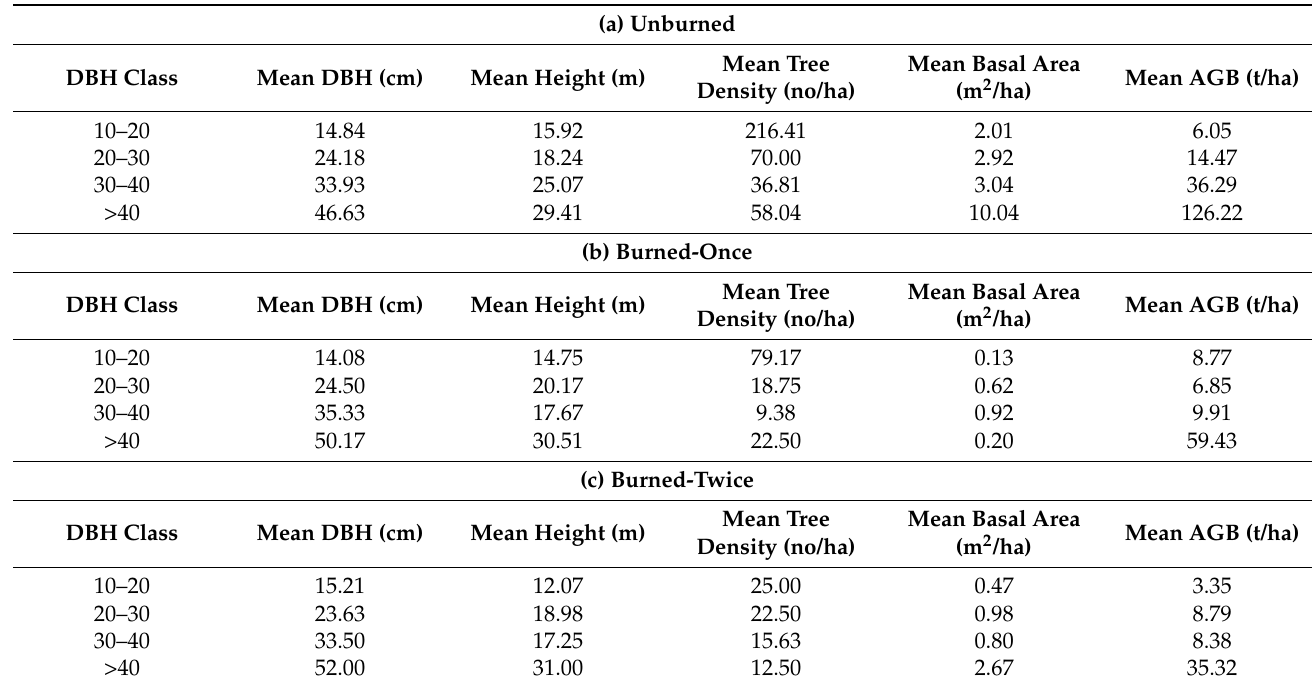
Table 3. Forest structure by DBH classes for ( a ) unburned, ( b ) burned-once and ( c )